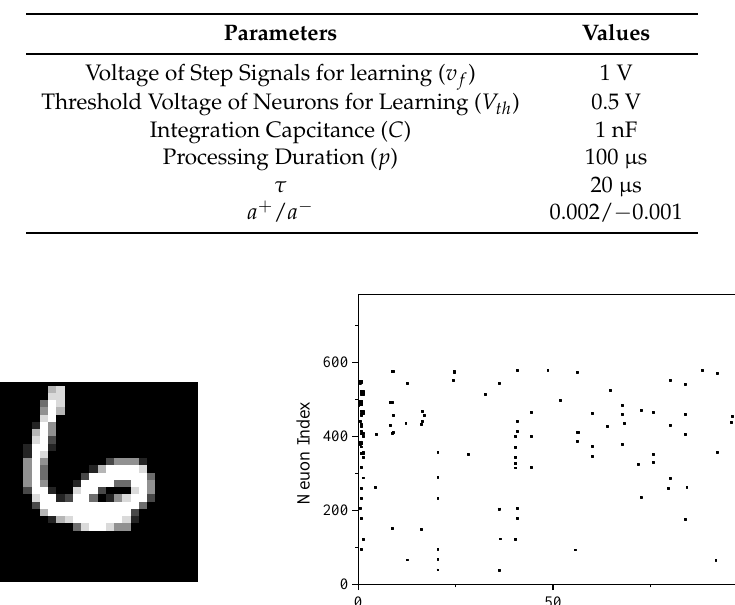
Table 1. Parameters for Simulation.